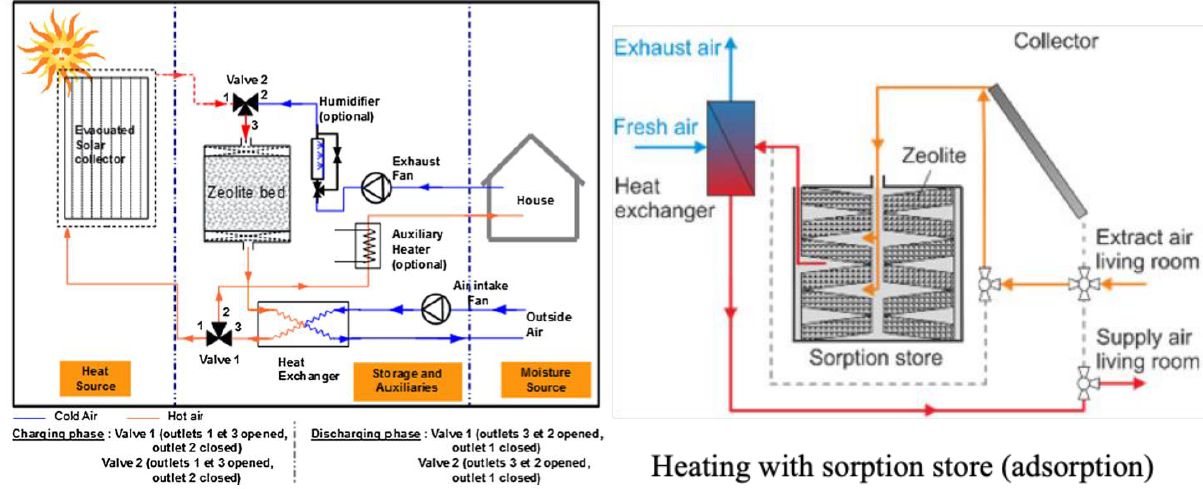
Figure 5. Building heat recovery system. Left side illustration from Tatsidjodoung et al. [13] Right side illustration from Weber et al. [14].